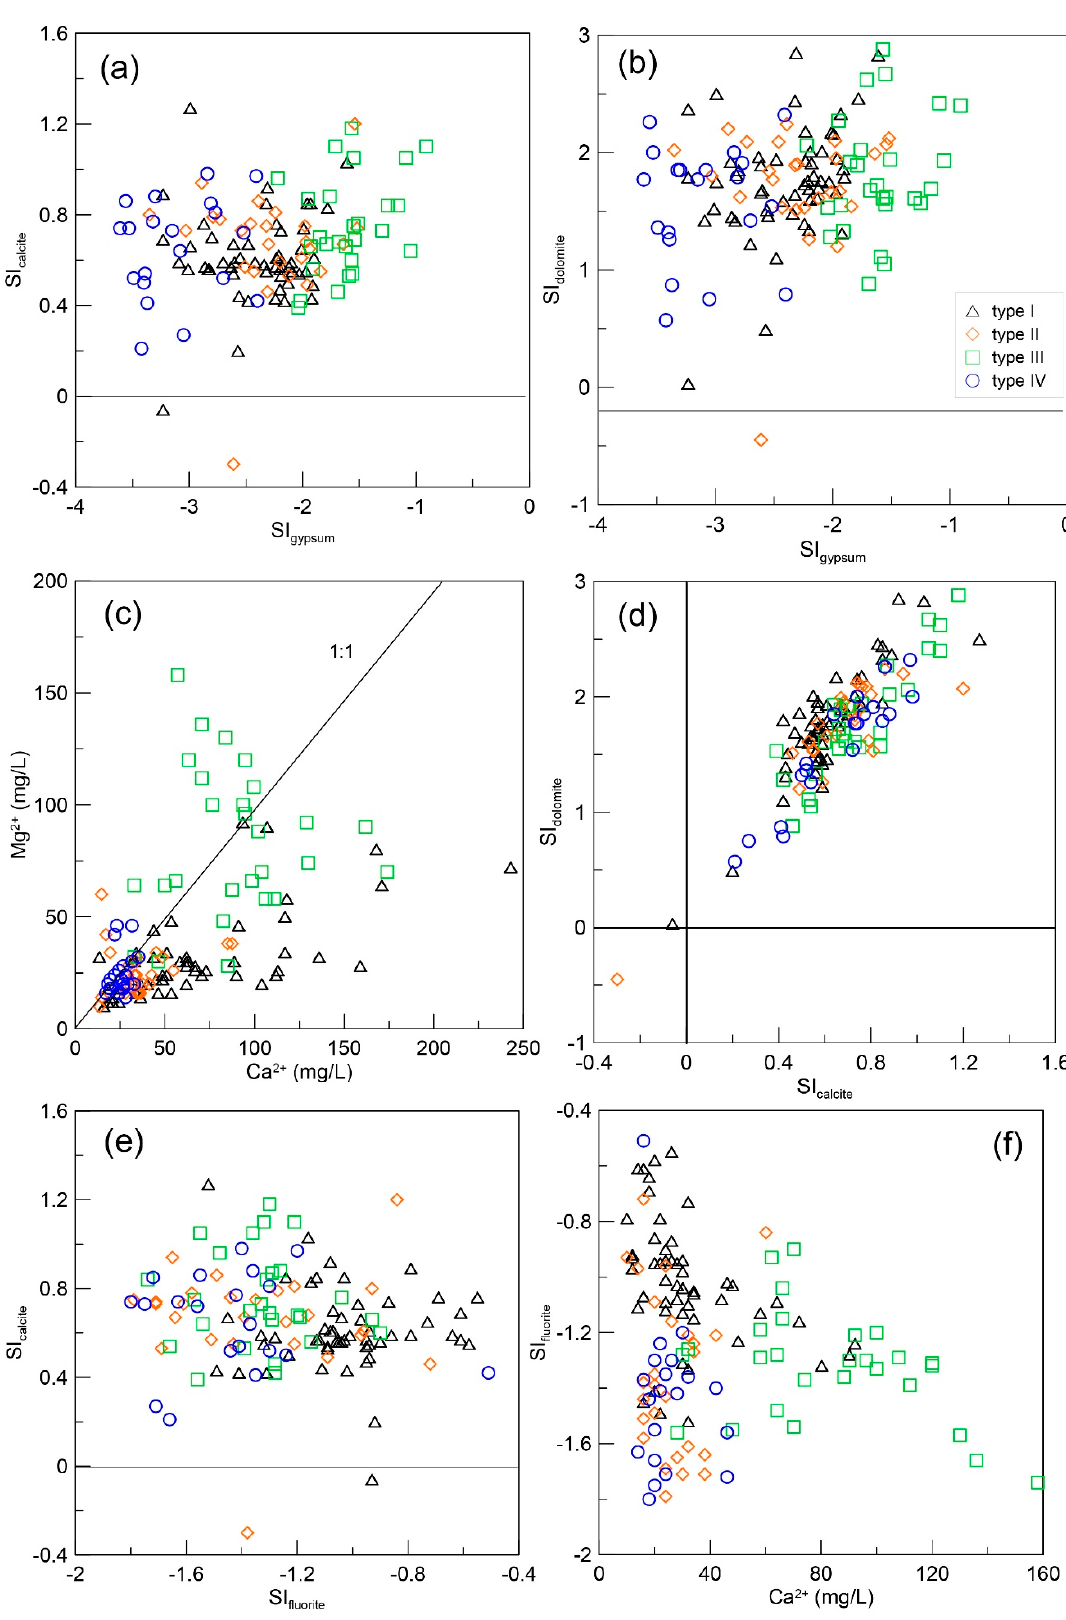
Figure 8. Saturation index (SI) scatterplots of ( a ) calcite, ( b ) dolomite versus gypsum, ( c ) Ca 2 + versus Mg 2+ , ( d ) SI of dolomite versus calcite, ( e ) SI of calcite versus fluorite, and ( f ) SI of fluorite versus Ca 2+ .